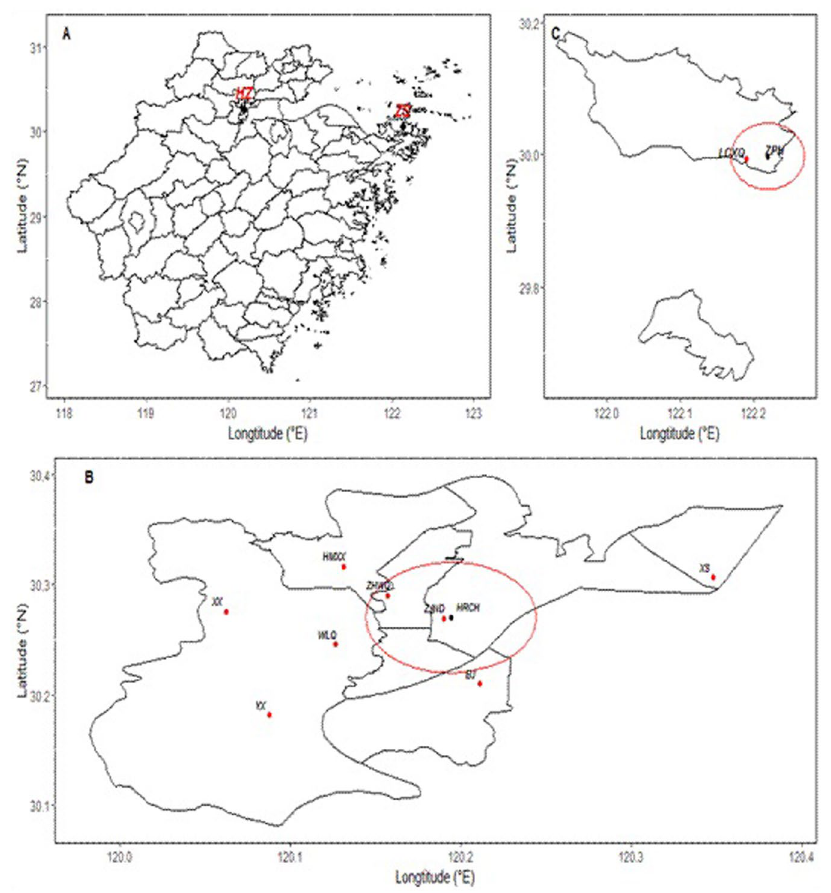
Figure 1. Locations of environmental monitoring stations and hospitals in HZ and ZS of the Zhejiang Province, China: ( A ) Map of the Zhejiang Province; ( B ) Map of urban HZ: the red points are the locations of stations; the black point is the location of the hospital; the labels on the map are abbreviations according to the first letter of the name; the red circle on the map is the 10-km range of Hangzhou Red Cross Hospital (HRCH). The map shows that the location of Zhaohuiwuqu (ZHWQ) and Zhejiangnongda (ZJND) both fall within the 10-km range of HRCH. ( C ) Map of urban ZS: the red points are the locations of stations; the black point is the location of the hospital; the labels on the map are abbreviations according to the first letter of the name; the red circle on the map is the 10 km range of Zhoushan People’s Hospital (ZPH). The map shows that the location of Linchengxinqu (LCXQ) falls within the 10-km range of ZPH. The figure was generated by R 64 3.3.1 with Package ggplot 2 version 2.2.1 (https://cran.r-project.org/web/packages/ggplot2/index.html) (H.Wickham. ggplot2: Elegant Graphics for Data Analysis. Springer-Verlag New York,